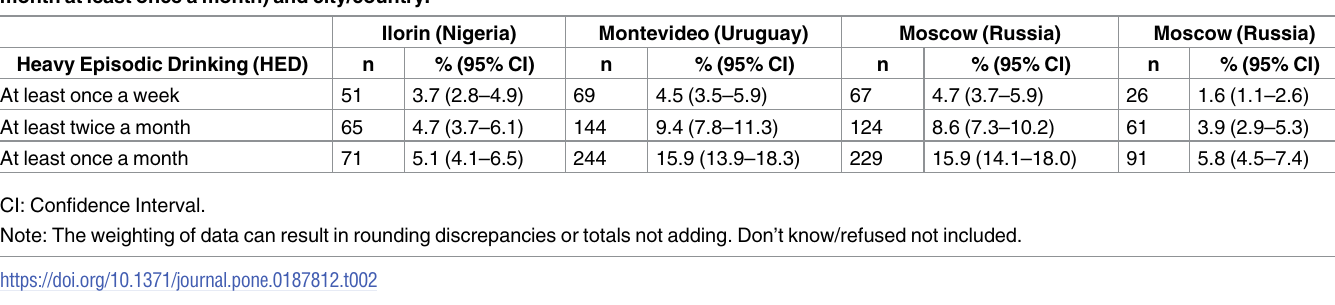
Table 2. Heavyepisodic drinking (HED) (five or more drinks) for three levels of frequency of heavy drinking (at least once a week, at least twice a month at least once a month) and